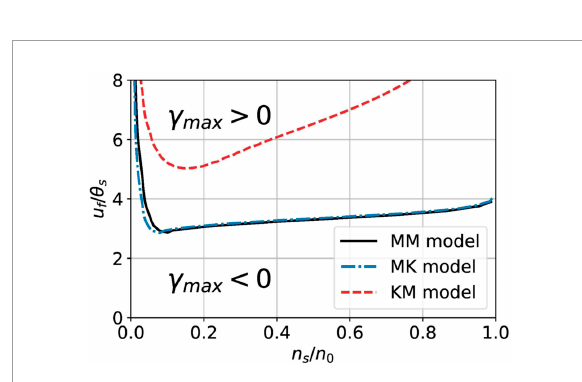
FIGURE 5 EAI threshold of the relative drift u f / θ s for different fractions of slow-MPS electrons n s / n 0 in three models. The MPS ratio θ f / θ s = 10 is fixed in this figure.